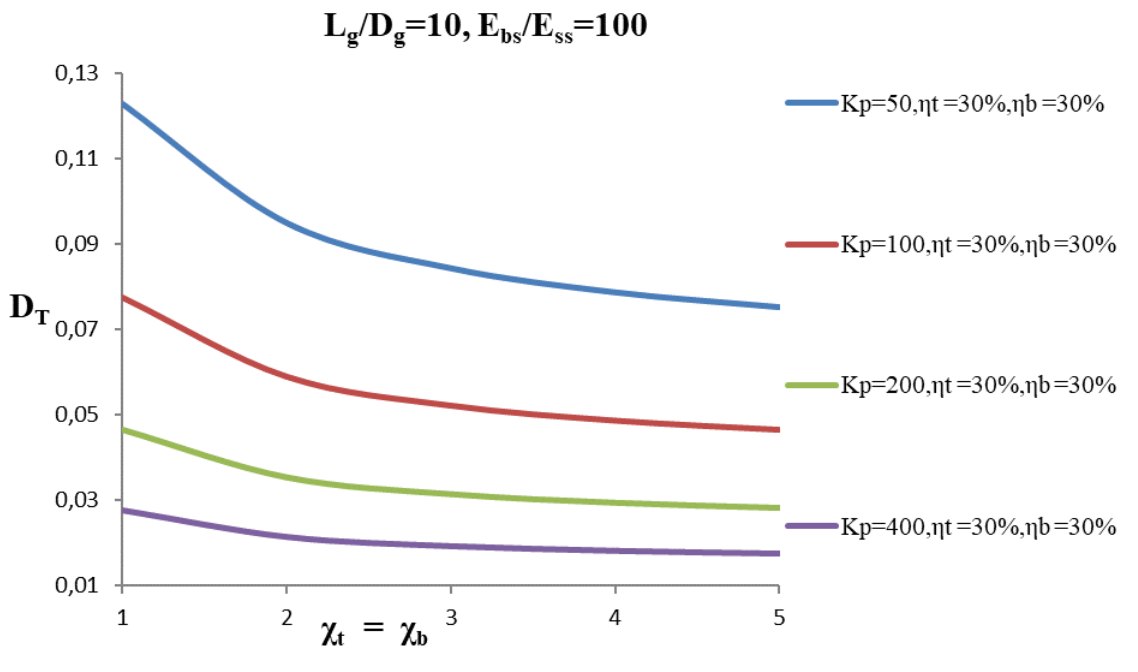
, with strengthening factor for the top, χ T ; PLST of GP, η p